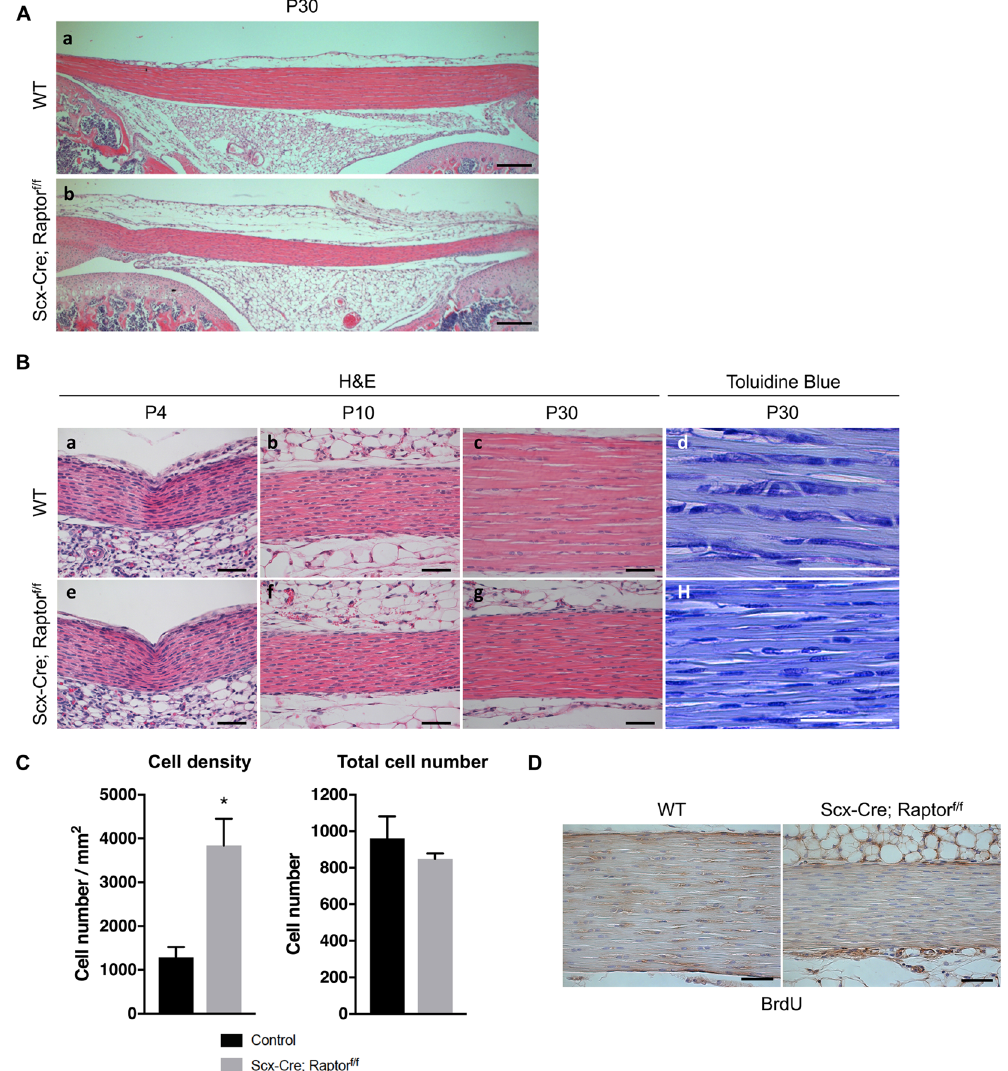
Figure 1. Loss of mTORC1 signaling impairs postnatal maturation of patellar tendons. ( A ) Hematoxylin and Eosin (H&E) staining of patellar tendons from wild-type (WT) (a) and Scx-Cre; Raptor f/f littermates (b) at postnatal day 30 (P30). Scale bars indicate 200 μ m. ( B ) H&E and toluidine blue-stained sections of patellar tendons from WT (a–d) and Scx-Cre; Raptor f/f littermates (e–h) at postnatal day 4 (P4), day 10 (P10), and day 30 (P30). Scale bars indicate 50 μ m. ( C ) Quantification of cell density and total cell number using H&E and toluidine blue-stained sections of patellar tendons (n = 3, * p < 0 . 05 ). ( D ) BrdU staining of patellar tendons from WT and Scx-Cre; Raptor f/f littermates at P30. Scale bars indicate 50 μ